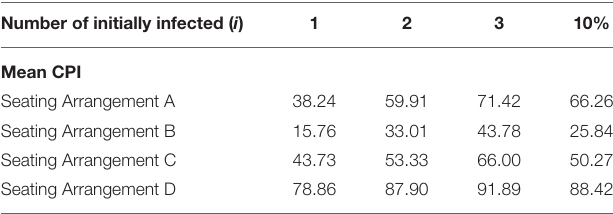
TABLE 3 | CPI for the four seating arrangements with transmission rate γ =